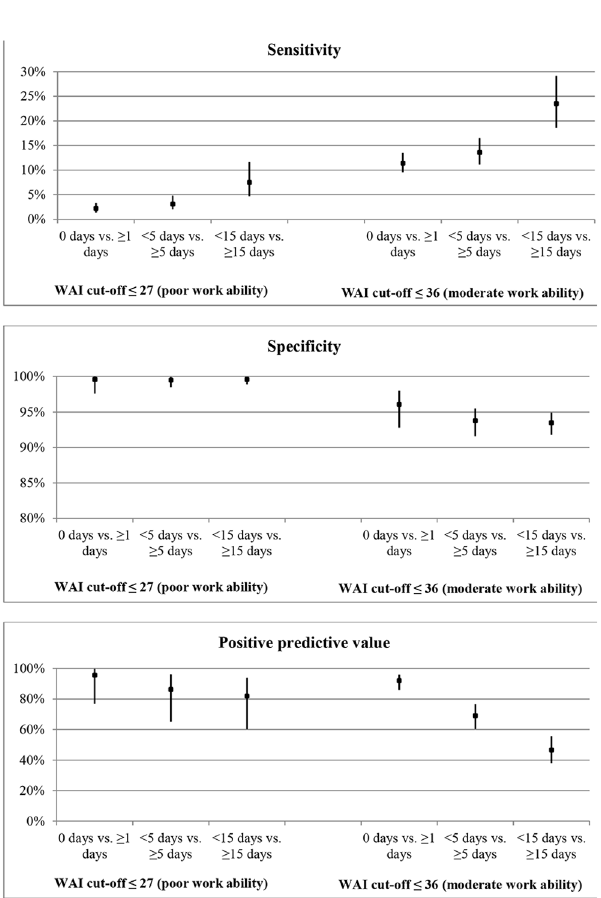
Fig 2. Test characteristics (sensitivity, specificity, and positive predictive value) at different cut-off values of the work ability index (WAI) for different durations of sickness